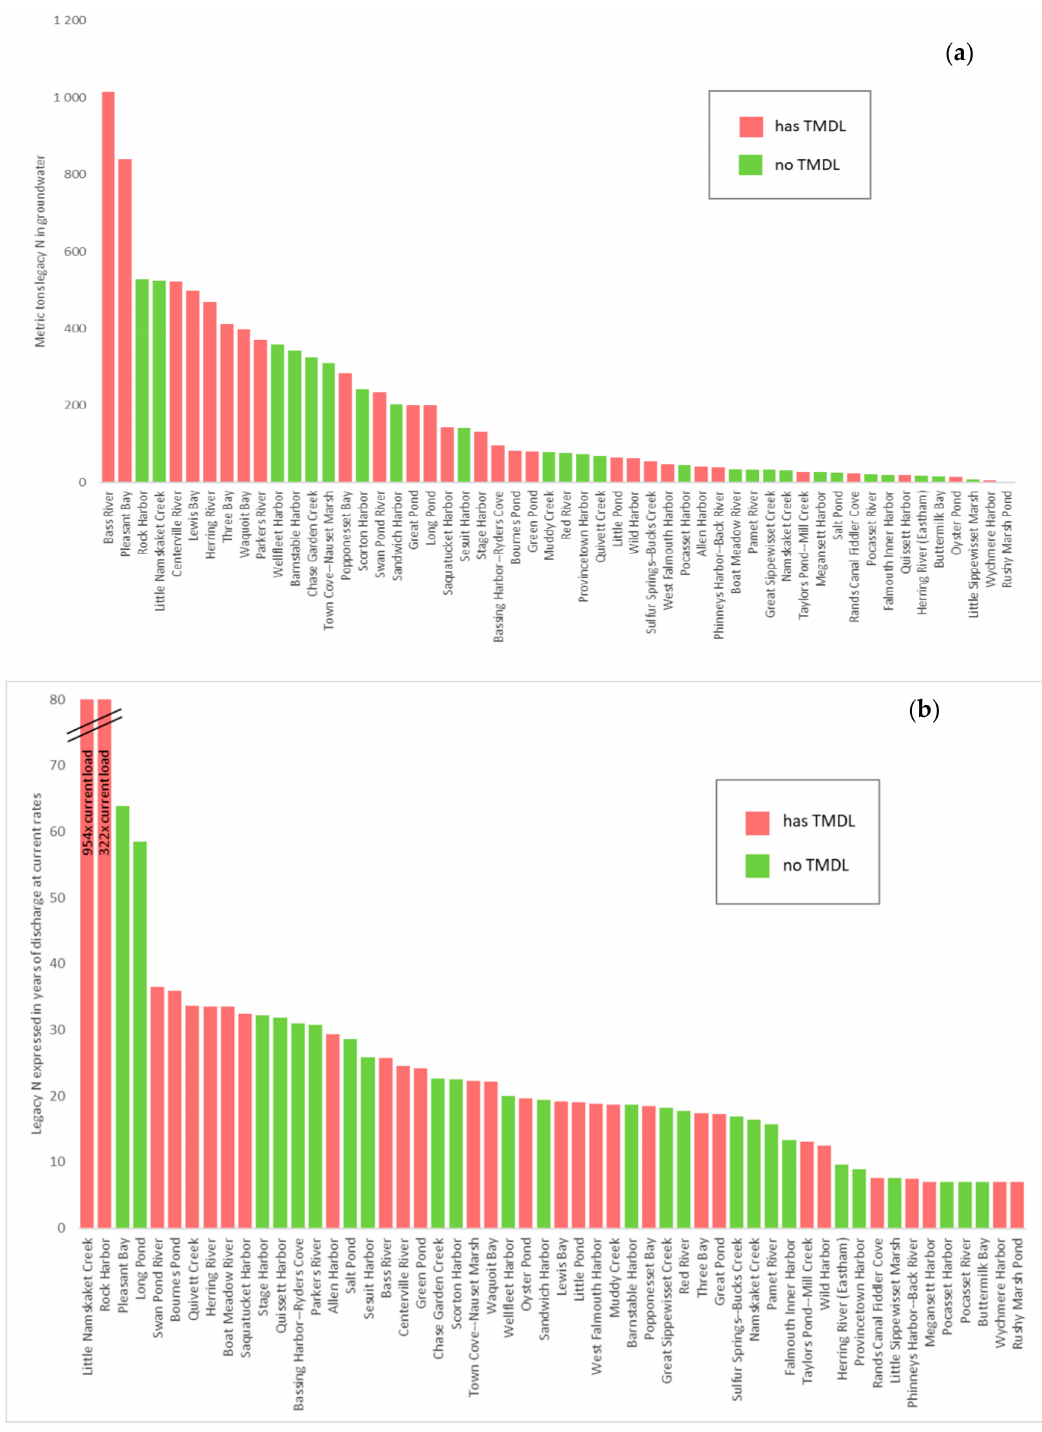
Figure 6. Legacy N load in groundwater in Cape Cod embayment watersheds (from 2025 to 2150). This was calculated by running a simulation where all N non-point sources were turned off in 2020 and the remainder of N in the system was allowed to travel over time to reach the respective bays. Expressed in ( a ) absolute units (tons N), ( b ) expressed in multiples of 2020 annual load. Bays with final TMDL in place indicated by red columns, and green columns indicate TMDL not required or not in place